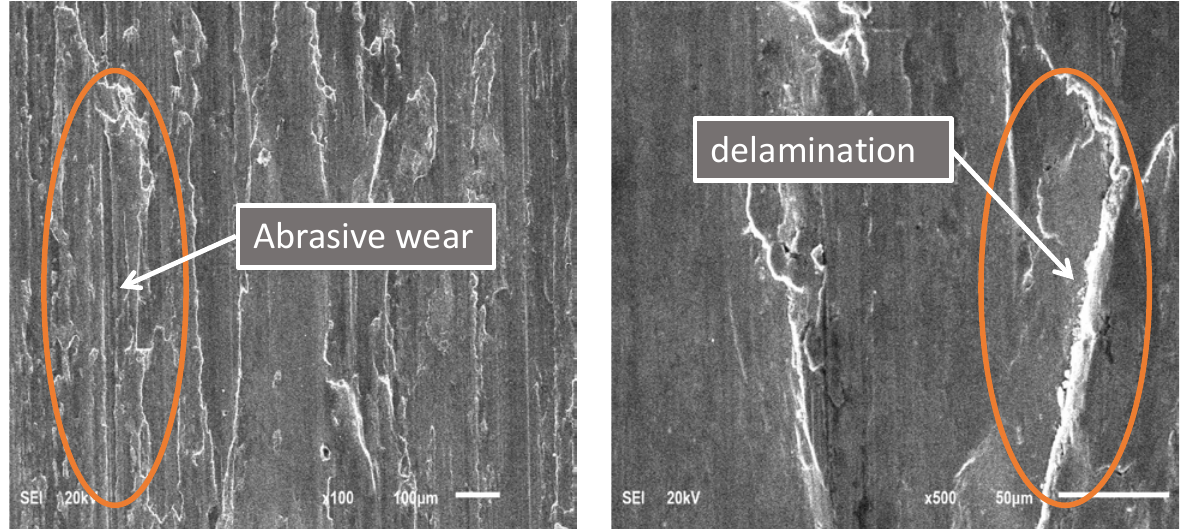
Figure 7. SEM images of the P110 worn casing sample (S0) tested under dry conditions at 115 rpm and 1000 N for 40 min.